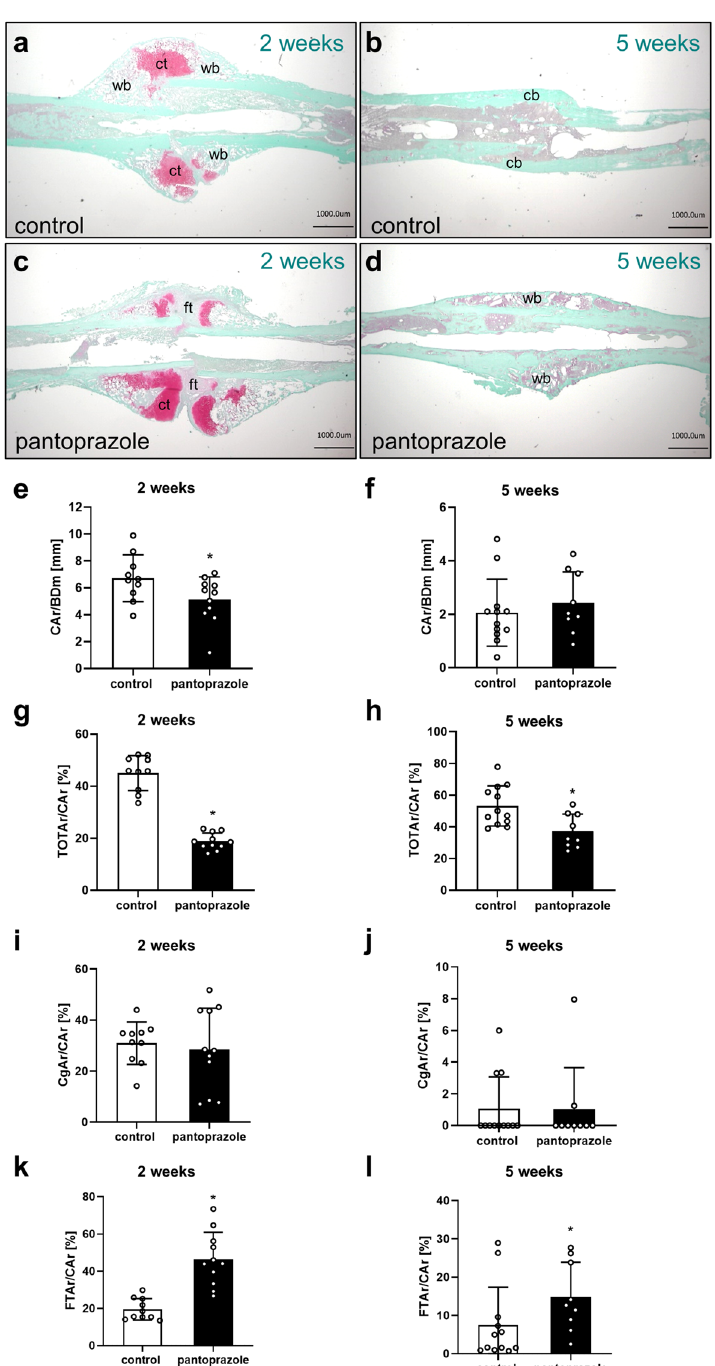
Figure 3. Histological and histomorphometrical analyses of mice femora. Representative histological images 2 weeks ( a , c ) and 5 weeks ( b , d ) after fracture healing in controls ( a , b ) and pantoprazole-treated animals ( c , d ). Fibrous tissue (ft), cartilage tissue (ct), woven bone (wb) and cortical bone (cb) are indicated. Scale bars: 1000 µm. ( e , f ) Histomorphometric analysis of the total callus area ( CAr ) in relation to the diameter of the femur ( BDm ) at 2 weeks ( e ) and 5 weeks ( f ) after fracture healing in control (white bars) and pantoprazole-treated animals (black bars). ( g – l ) Histomorphometric analysis of the tissue distribution within the callus, including total osseous tissue callus area/total callus area ( TOTAr/CAr , [%]) ( g , h ), cartilaginous callus area/total callus area ( CgAr/CAr , [%]) ( i , j ), and fibrous tissue callus area/total callus area ( FTAr/CAr , [%]) ( k , l ) at 2 weeks ( g , i , k ) and 5 weeks ( h , j , l ) after fracture healing in controls ( white bars ) and pantoprazole-treated animals ( black bars ). Means ± SD; n = 9–12; *p < 0.05 vs.